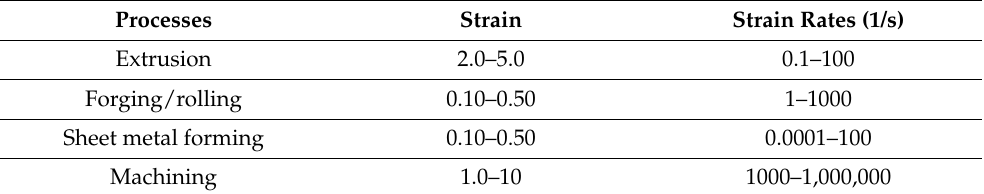
Table 4. Typical hot working parameters of some metalworking processes